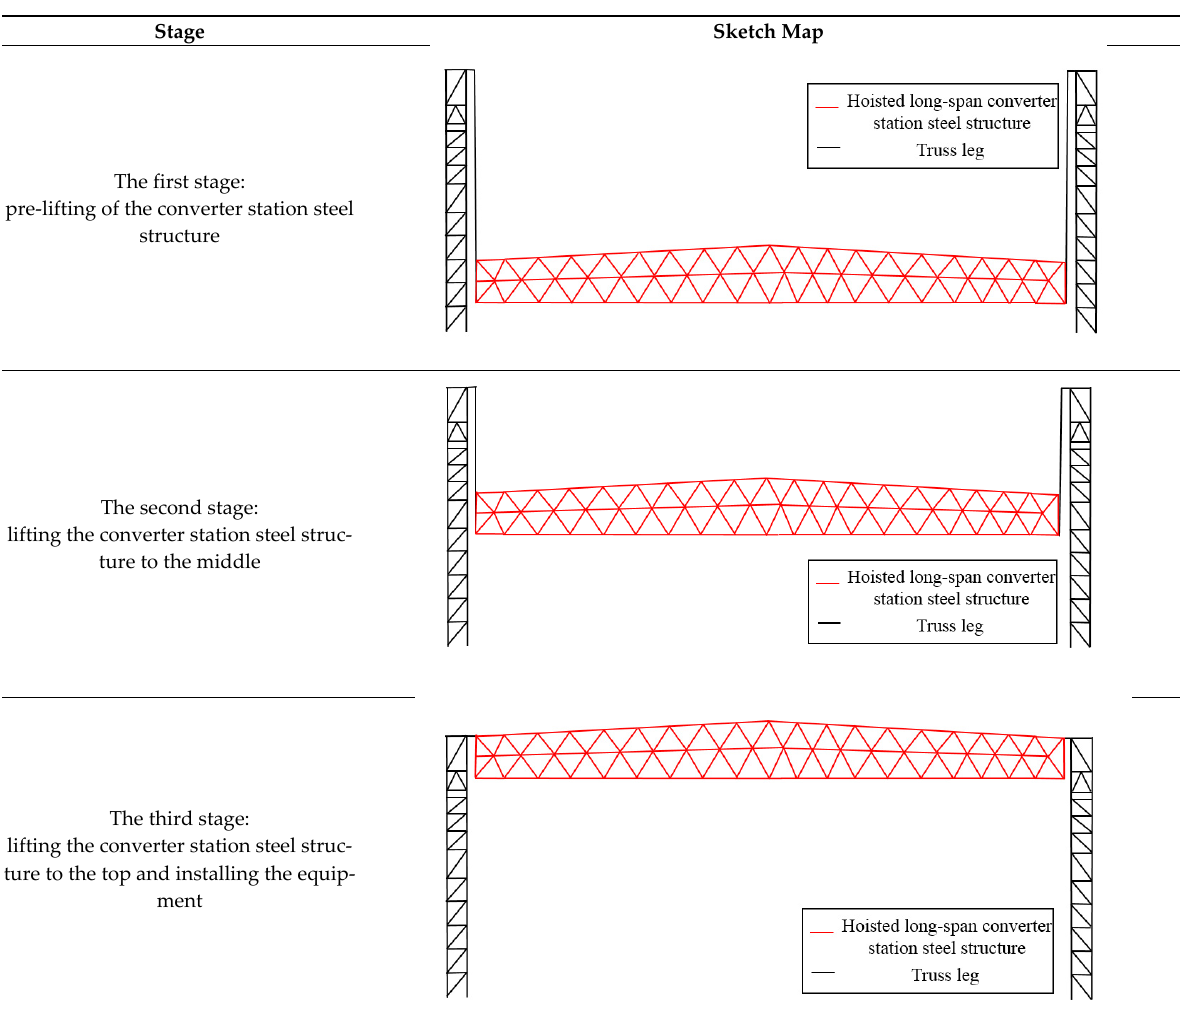
Figure 12. Numerical model: ( a ) converter station steel structure and ( b ) hoisting point. Stage Sketch Map